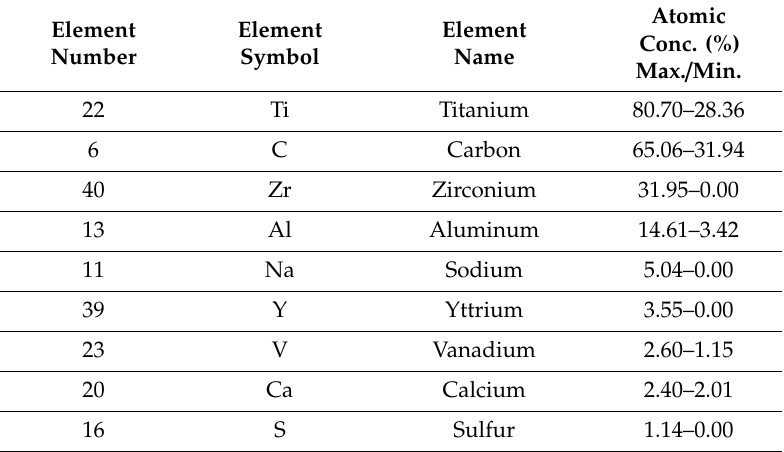
Table 4. Chemical analysis of particulate residues on monotype titanium samples before ultrasonic cleaning by element and maximum / minimum atomic concentration.